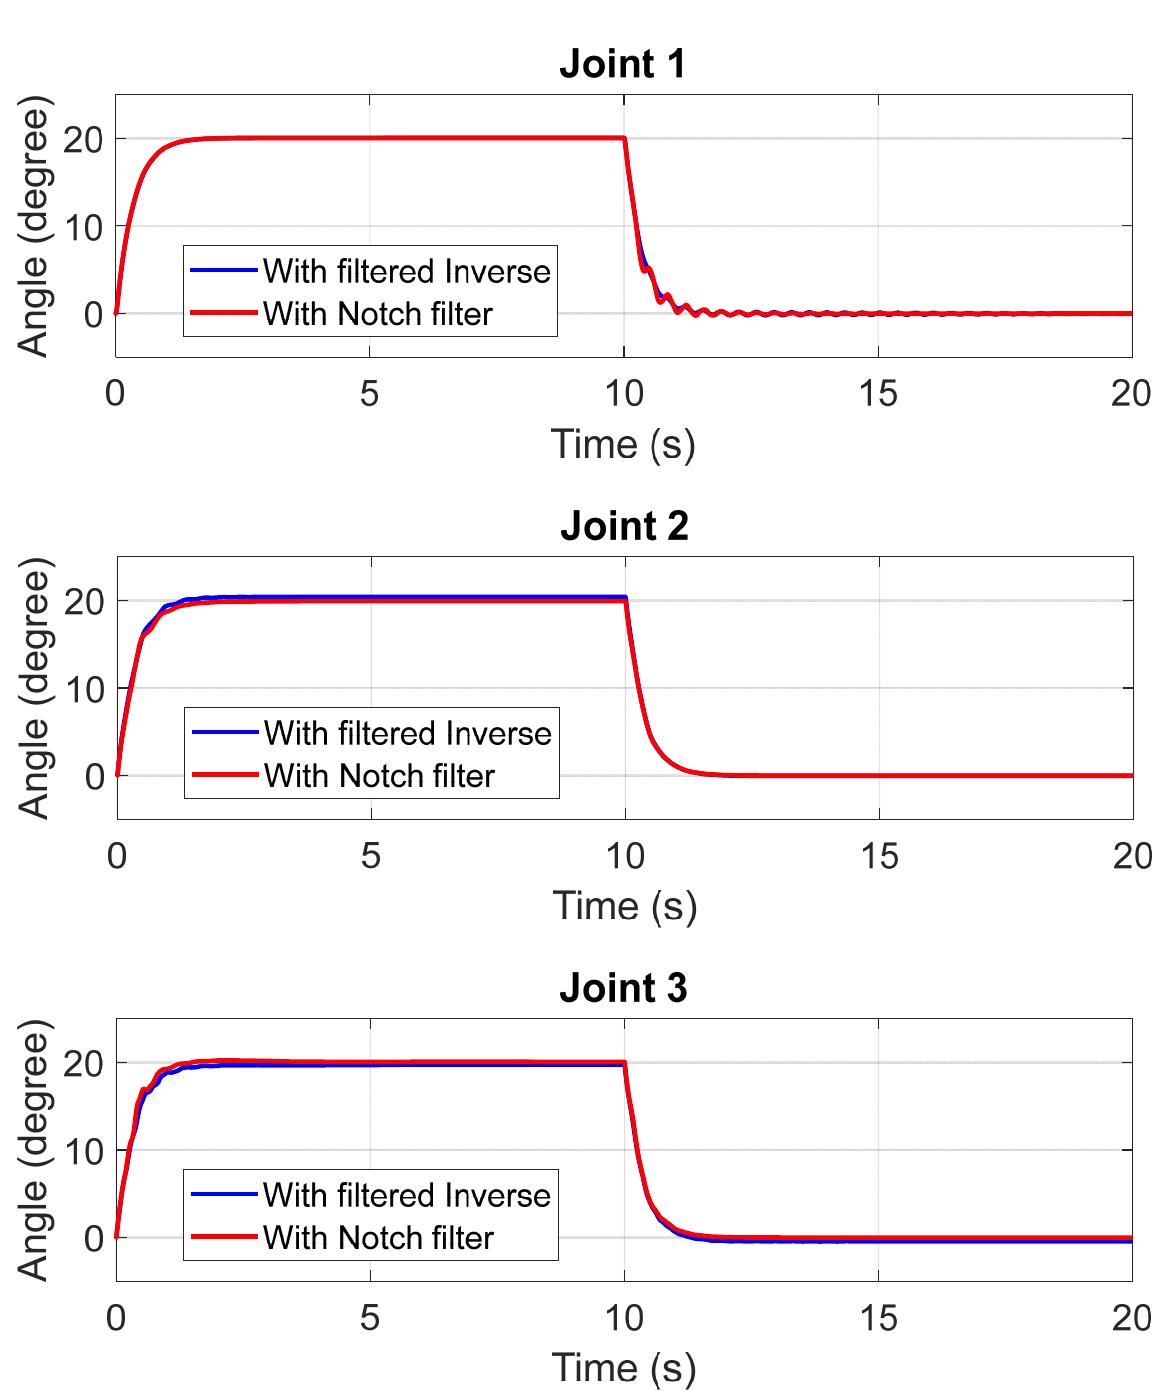
Figure 10. Joint angles for filtered and inverse model.